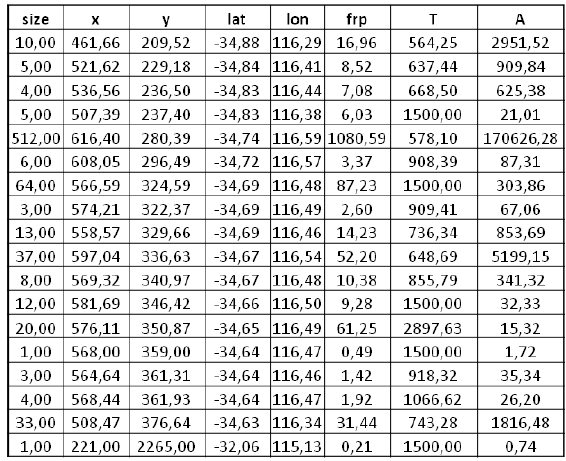
Table 3. FRP Table for the data take 10.2.2015 04:42